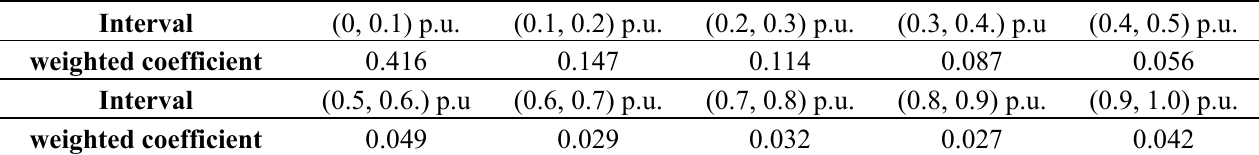
Table 8. The weighted coefficient in each interval.